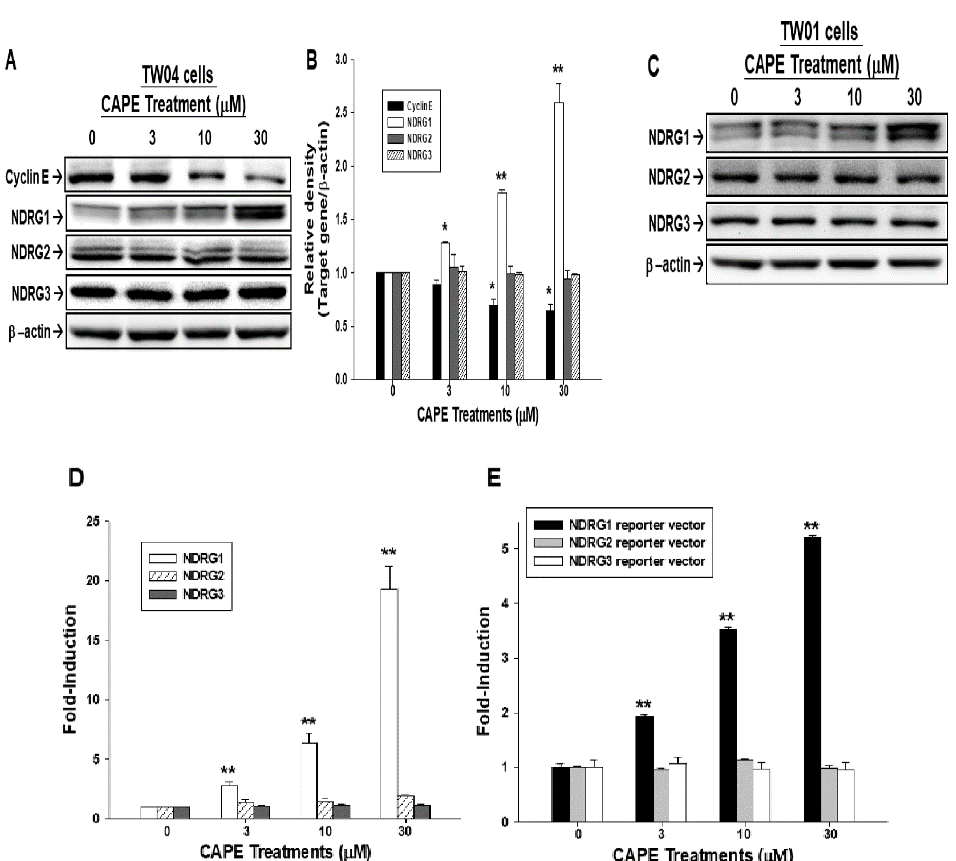
Figure 2. CAPE induces NDRG1 and cyclin E expressions in NPC cells. ( A ) TW04 cells were treated by CAPE in indicated concentrations for 24 h. The expressions of targeted proteins were determined by the immunoblot assay. ( B ) The quantitative data were expressed as the intensity of protein bands of the target genes/β-actin relative to the control solvent-treated group ( n = 3). ( C ) The presentative immunoblot blot showing targeted proteins expressions in TW01 cells after indicated concentrations of CAPE treatment for 24 h. ( D ) Cells were treated with indicated concentrations CAPE for 24 h and the expression of the mRNA levels of targeted proteins were determined using RT-qPCR assays. Data were presented as mean fold-induction of the mRNA levels relative to the control solvent-treated group ( ± SE, n = 3). ( E ) The different report vectors were transfected into TW04 cells for 24 h, and cells were then treated by indicated concentrations CAPE for 24 h. Data were presented as the mean percentage of luciferase activity induced by the CAPE treatment relative to the control solvent-treated group ( ± SE, n = 6). (* p < 0.05, ** p <